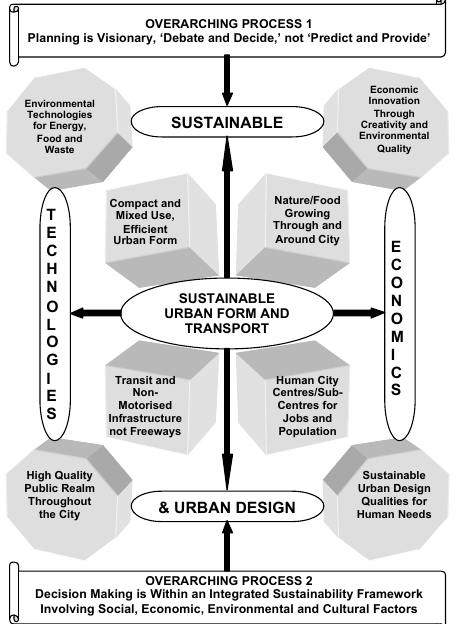
Figure 1. A conceptual model for eco-cities based on 10 key principles in urban planning, urban transport, urban design, and planning process considerations. Source: [4].